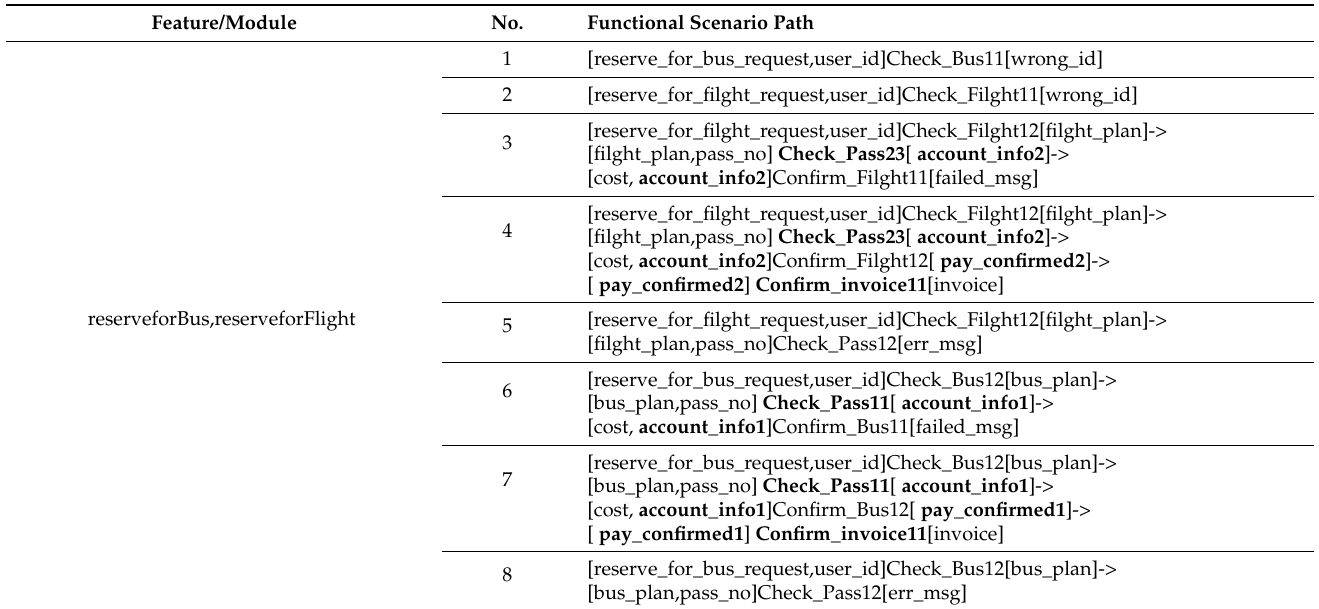
Table 4. The integrated functional scenario paths of ReserveforBus and ReserveforFlight